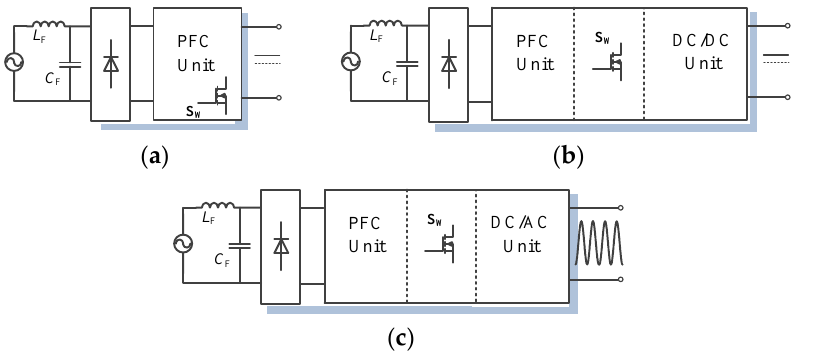
Figure 1. Structures of the SSC with APFC function. ( a ) Typical single-stage AC/DC converter. ( b ) Integrated single-stage AC/DC converter. ( c ) Integrated single-stage AC/AC converter.